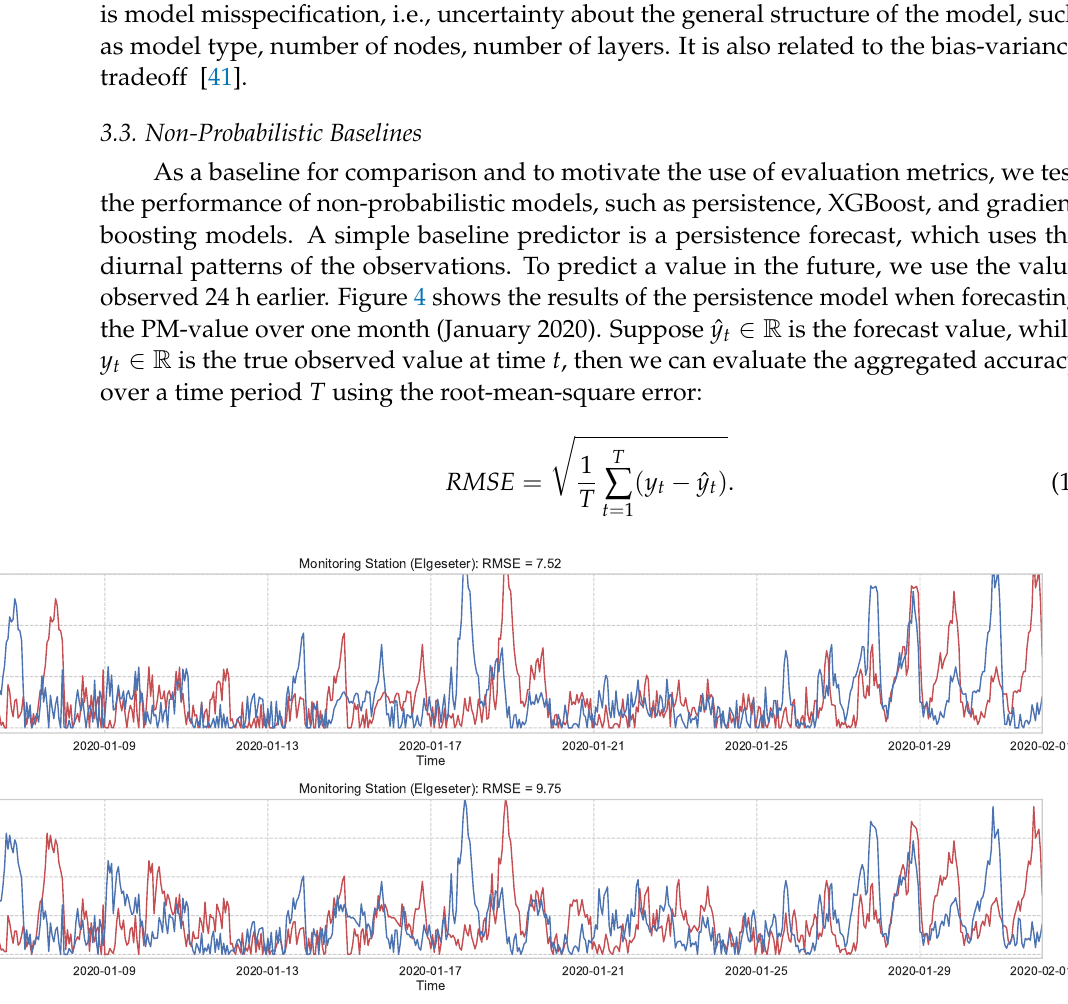
Figure 4. Persistence forecast of air pollutant over one month in one representative monitoring